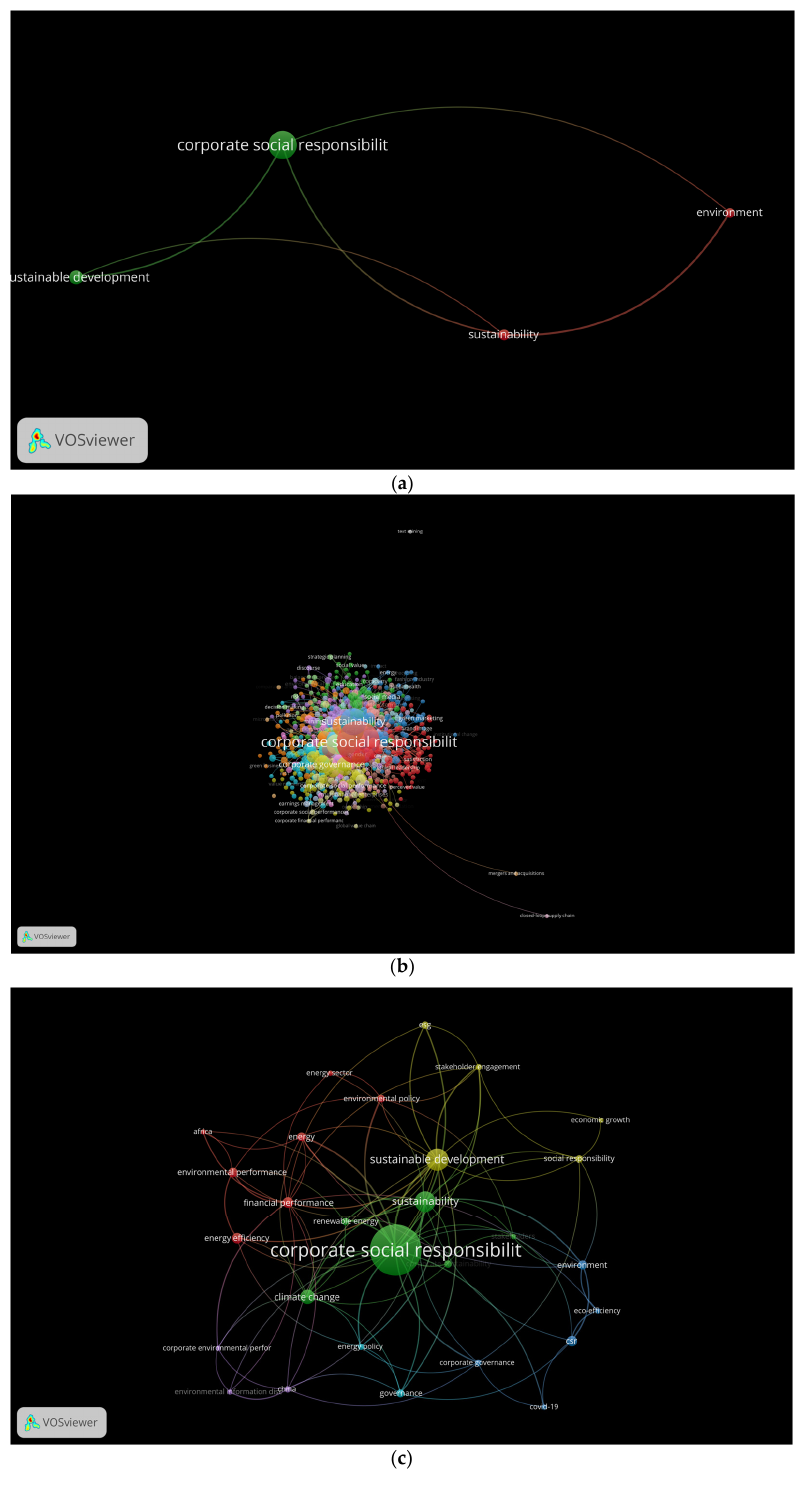
Figure 4. ( a ). Co-occurrence network of author keywords of CSR, environment and energy. ( b ). Co-occurrence network of author keywords of CSR and environment. ( c ). Co-occurrence